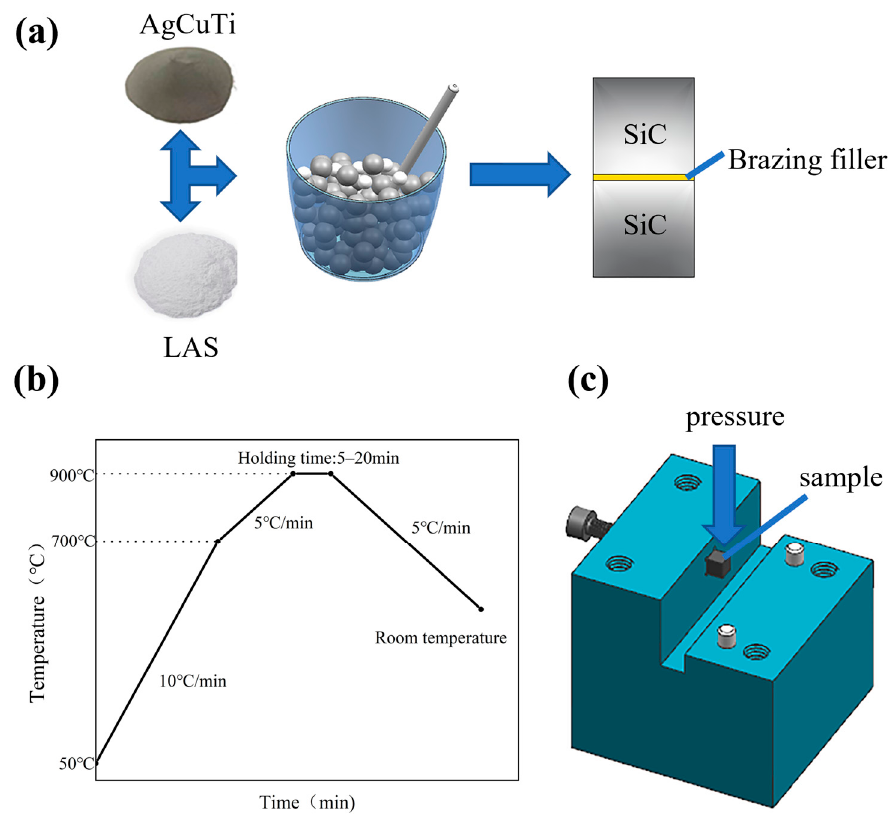
Figure 1. Schematic diagrams of ( a ) the assembly mode of brazing samples, ( b ) the curve of brazing process parameter and ( c ) shear strength test.